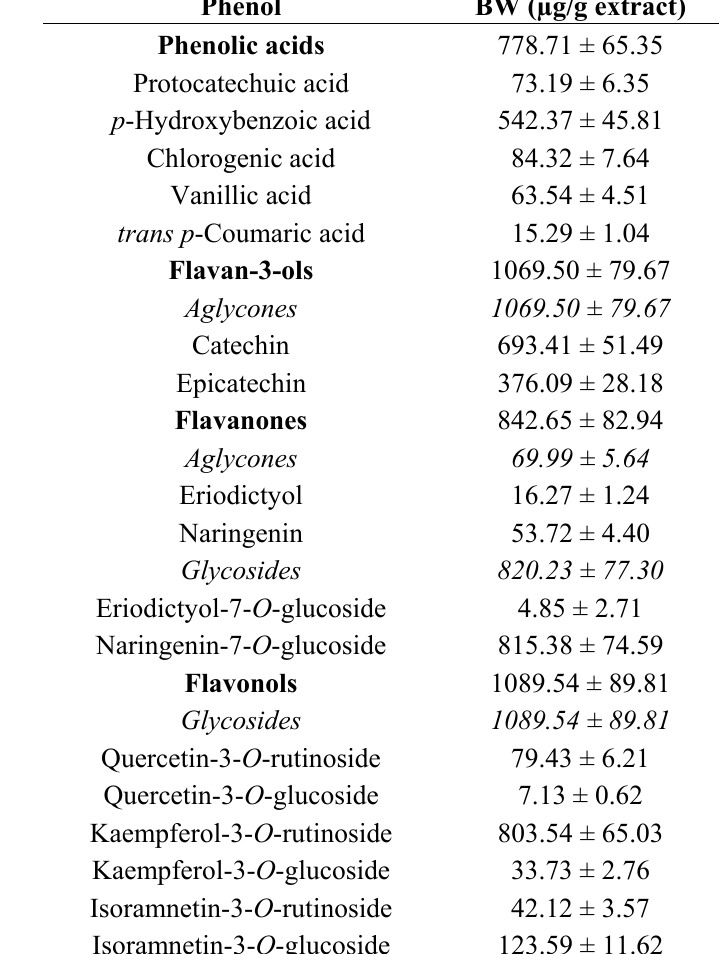
Table 1. Quantitative analysis of phenolics in the BW extract. Results are expressed as mean±SD of three independent